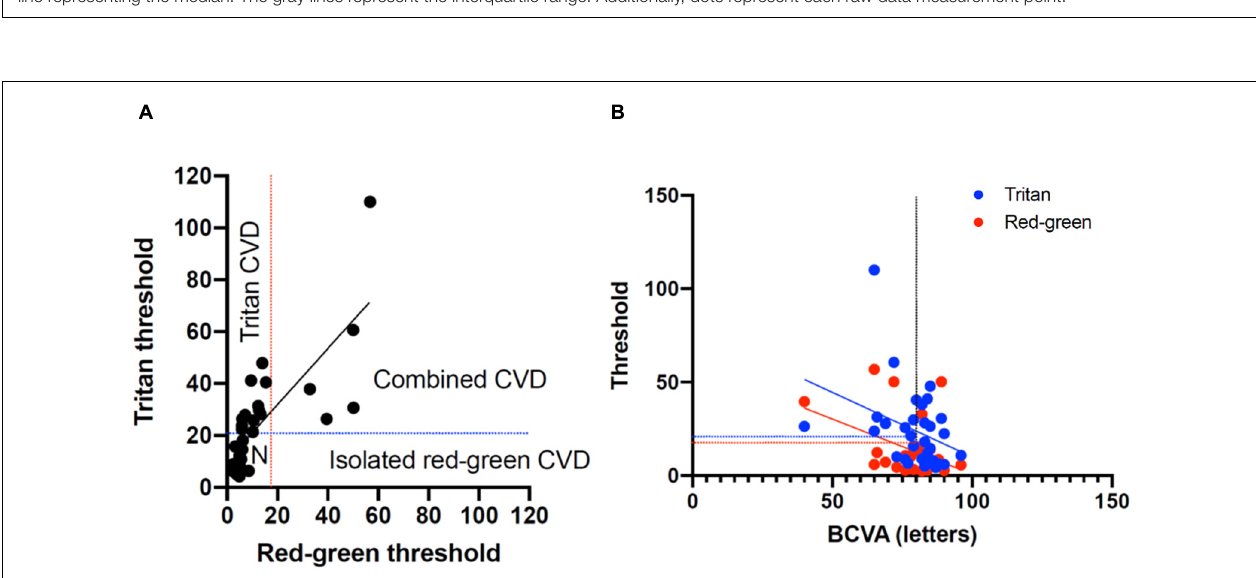
FIGURE 4 | (A) Classification of color vision defects (CVD) measured with the low vision Cambridge Color Test (lvCCT) with the regions of normal color vision, tritan loss, red-green loss, and combined loss labeled. (B) Correlation of best-corrected visual acuity (BCVA) with red-green and tritan color defects. The vertical dotted line shows 20/20 visual acuity. The blue and red lines show the upper 95% cutoff of normal for the tritan and red-green loss, respectively.